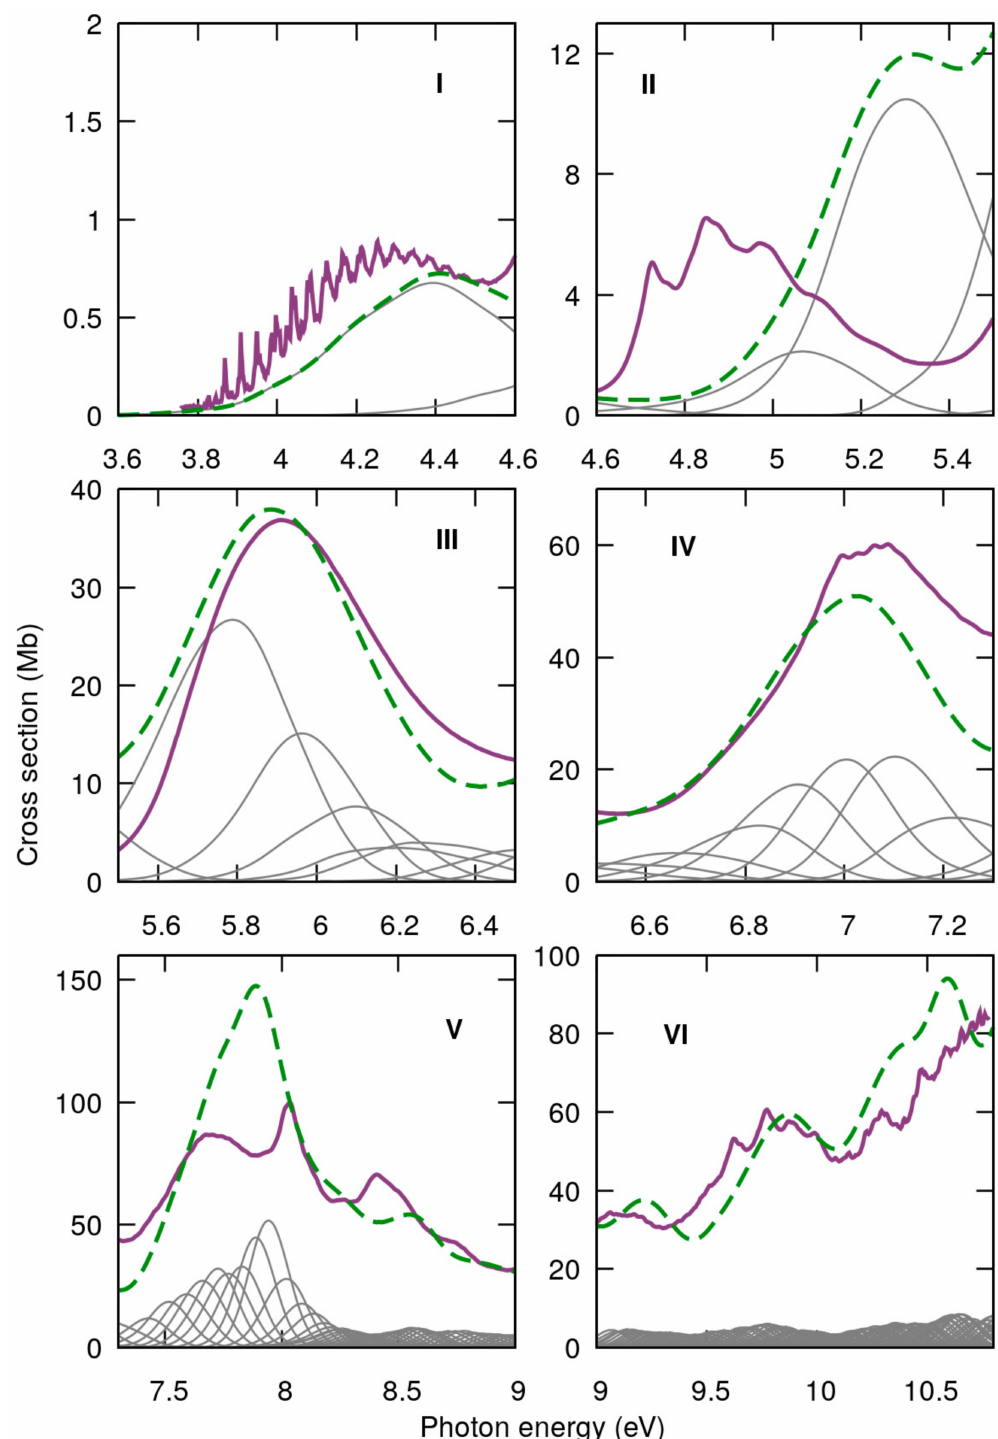
Figure 5. Comparison between measured (purple) and computed (green) absorption cross sections for 2-bromopyrimidine in the 3.7–10.8 eV photon energy range, separated into six absorption bands ( I – VI ). Individual contributions of the adiabatic excited states in